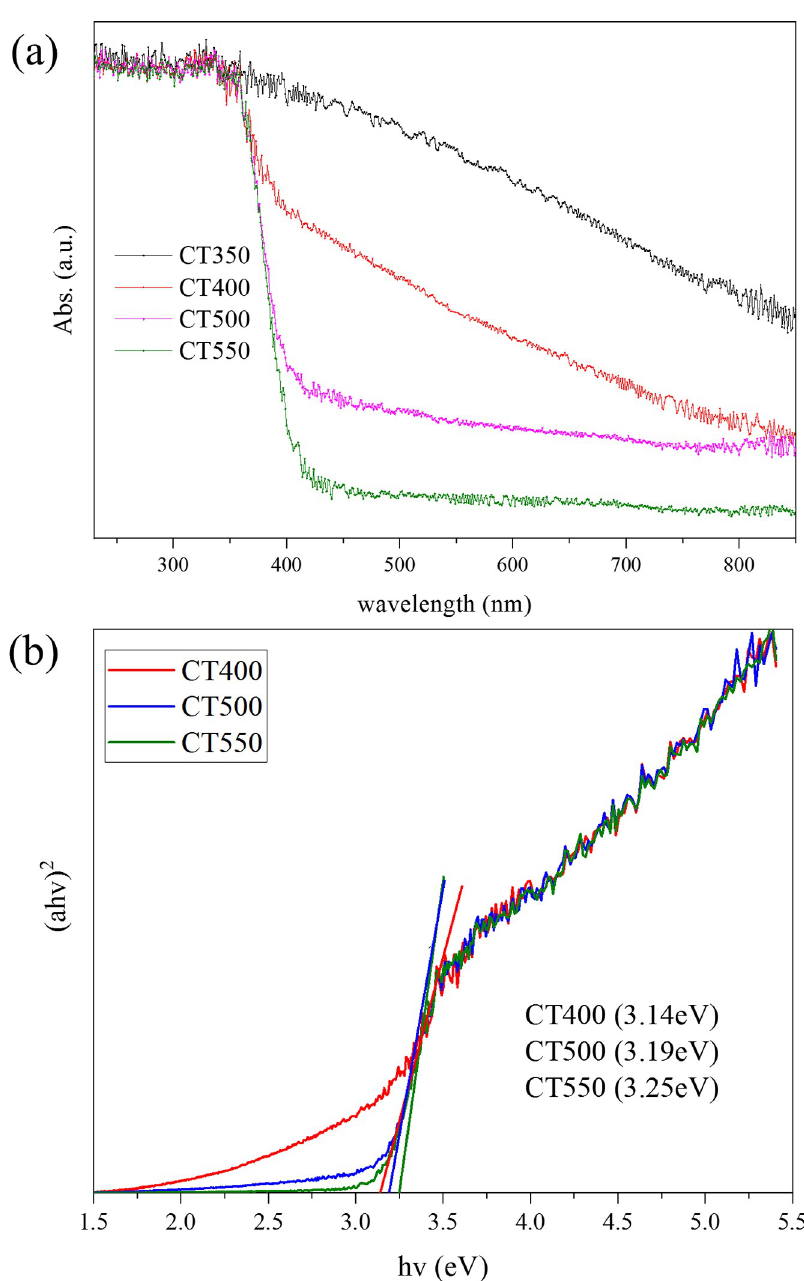
Fig 7. UV-vis diffuse reflectance spectra (a) and the band gap evaluation for linear dependence of ( α hv) 2 versus hv (b) for the